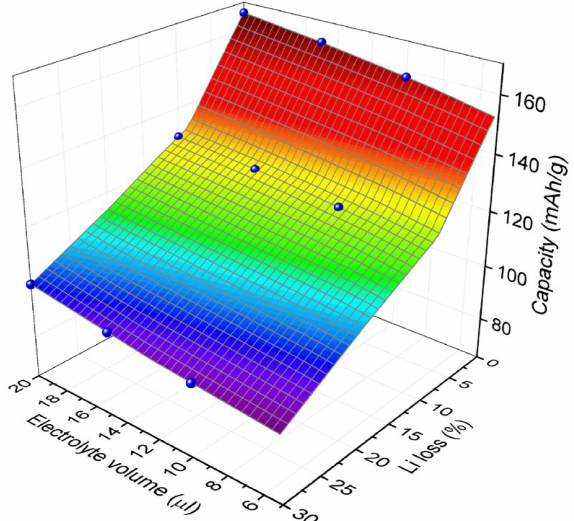
Figure 7. Three-dimensional graphs of the discharge capacities based on the cyclable lithium loss and electrolyte depletion at a discharge rate of 0.5 C; 3D surface plots are modeling results, and the spheres represent experimental